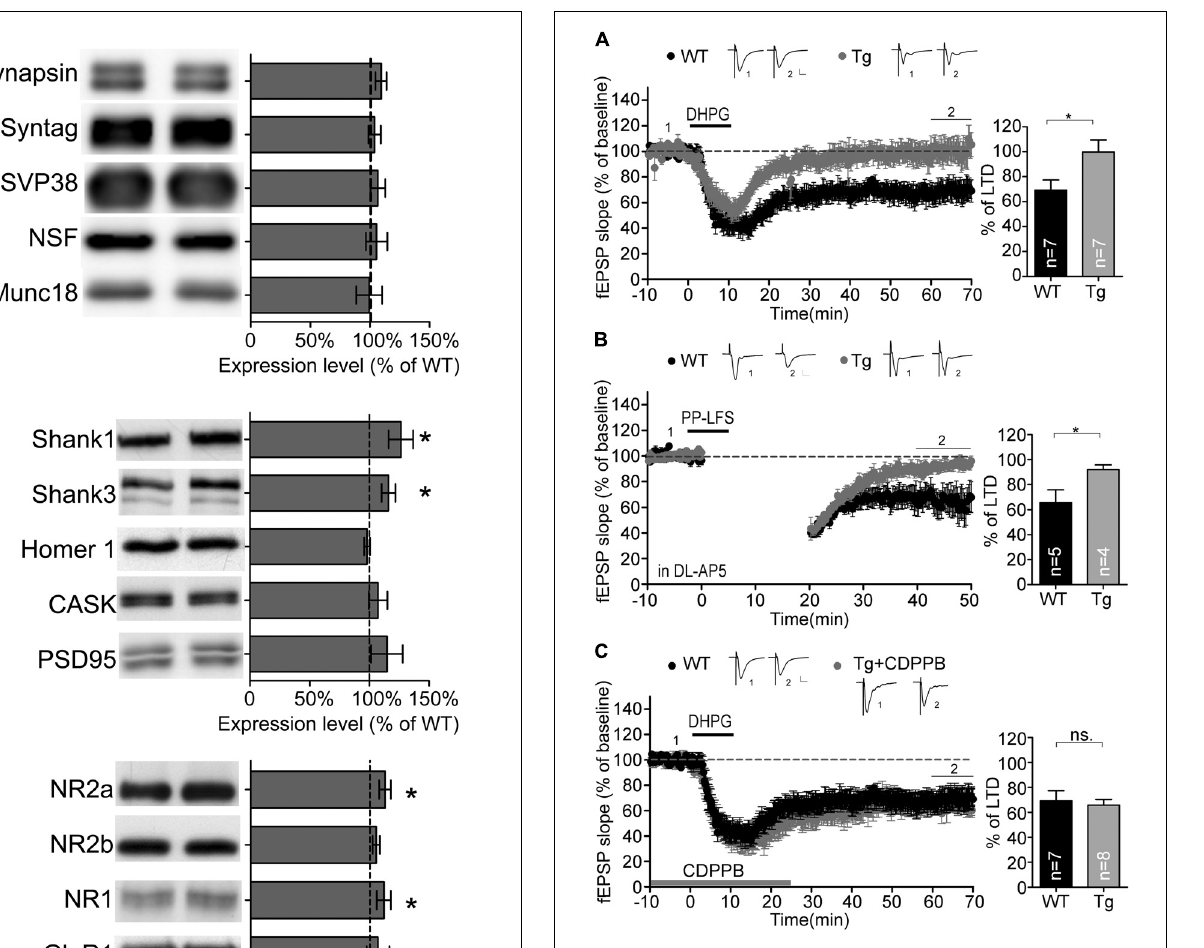
FIGURE 5 | Metabotropic GluR-dependent LTD is defective in the Sarm1 knockdown hippocampus. Chemically and electrically induced LTD were recorded in the hippocampal CA1.The fEPSP is shown plotted as a function of time, and the representative traces at the indicated time points (labeled by 1 and 2 in the figure) are shown above. mGluR- dependent LTD induced by (A) DHPG and (B) paired-pulse low frequency stimulation was impaired in Sarm1 knockdown brains. (C) CDPPB was bath applied from the baseline recording for 25 min and showed profound rescue of DHPG-induced LTD in the Sarm1 knockdown hippocampus. (A – C) The horizontal dashed lines indicate the average value of the normalized amplitude during the control period. Calibration: 0.2 mV, 10 msec. For both LTP and LTD, histograms summarizing the average of the fEPSPs of the last 10 min of recording are shown in the right panels.The data represent the mean plus SEM (for histograms) or ± SEM (for fEPSP slopes).The sample sizes ( n ) are indicated. * P < 0.05; ns, not